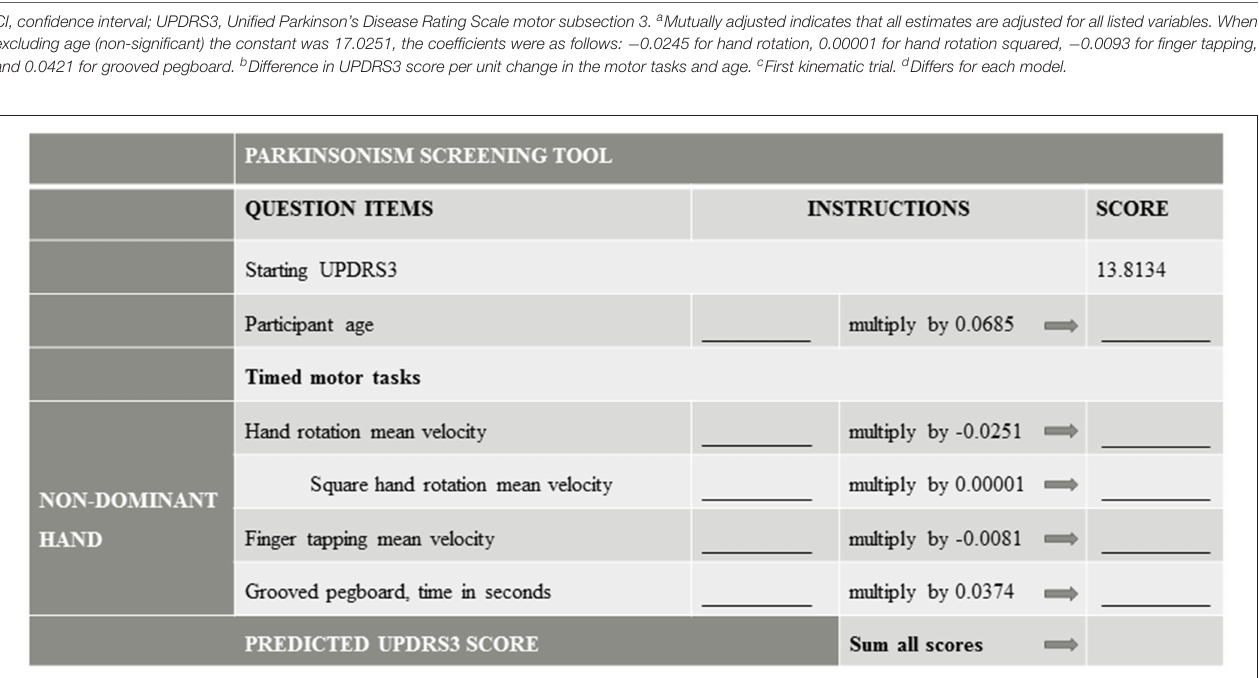
FIGURE 1 | Parkinsonism Screening Tool. A simple motor task screening tool based on the predictive model, which is shown in detail in Table 2 . UPDRS3, Unified Parkinson’s Disease Rating Scale motor subsection